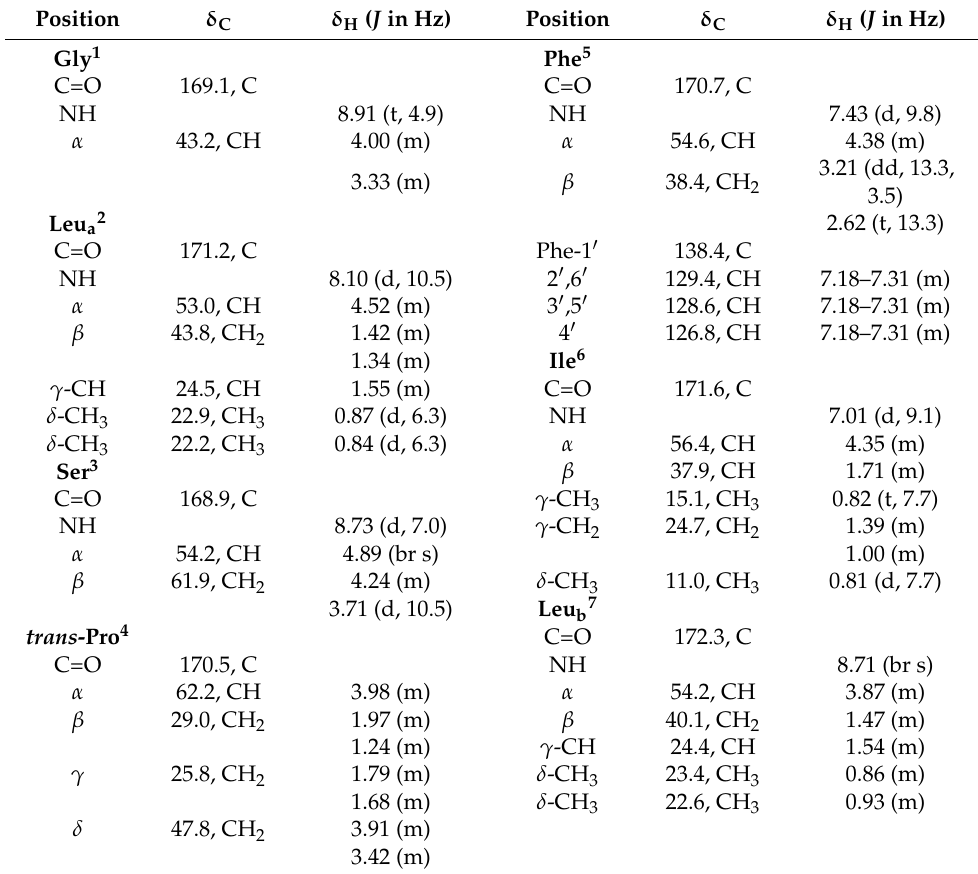
Table 3. 1 H and 13 C NMR data for dianthiamide C ( 3 ) (DMSO- d 6 , 700 MHz, d in ppm, J in Hz).